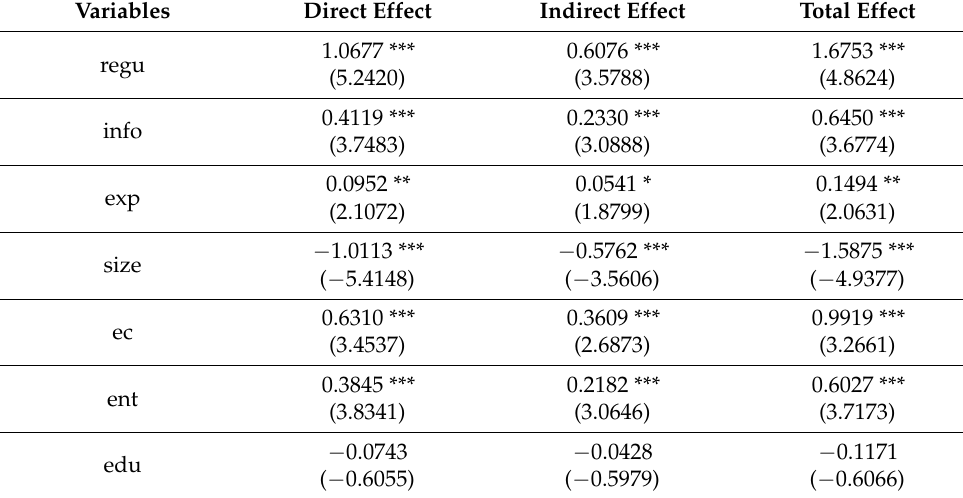
Table 7. Decomposition of the SAR spatial effects of variables on urban innovation capacity.